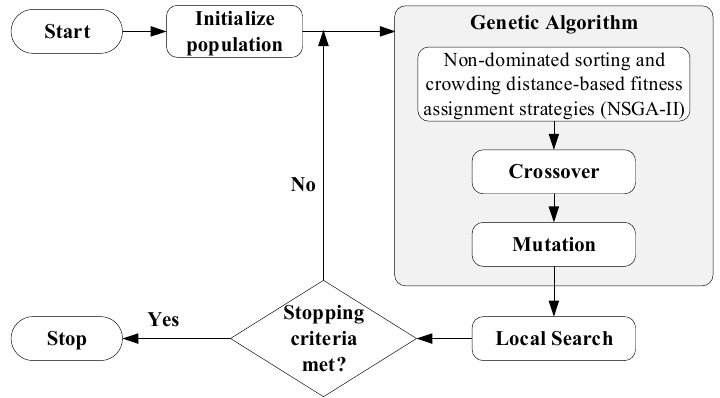
Figure 8. The flow chart of the hybrid strategy for